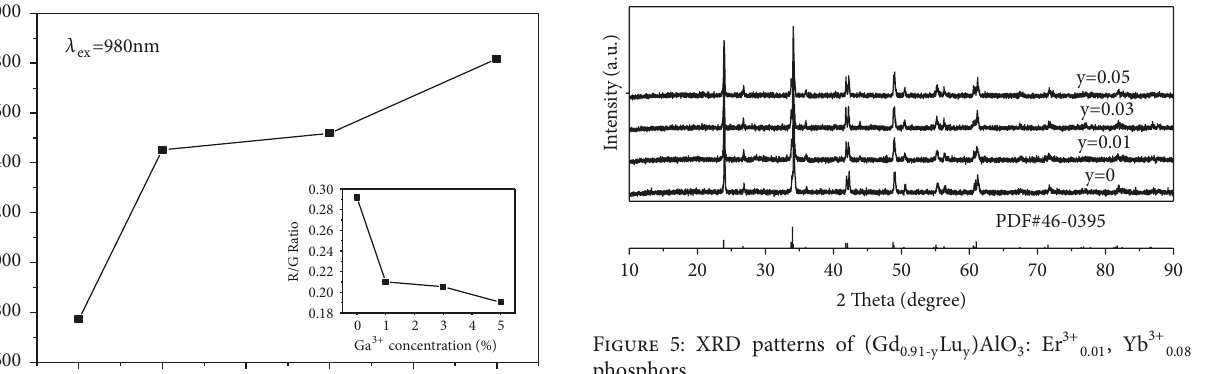
Lu y )AlO 3 : Er 3+ 0.01 , Yb 3+ 0.08 - y